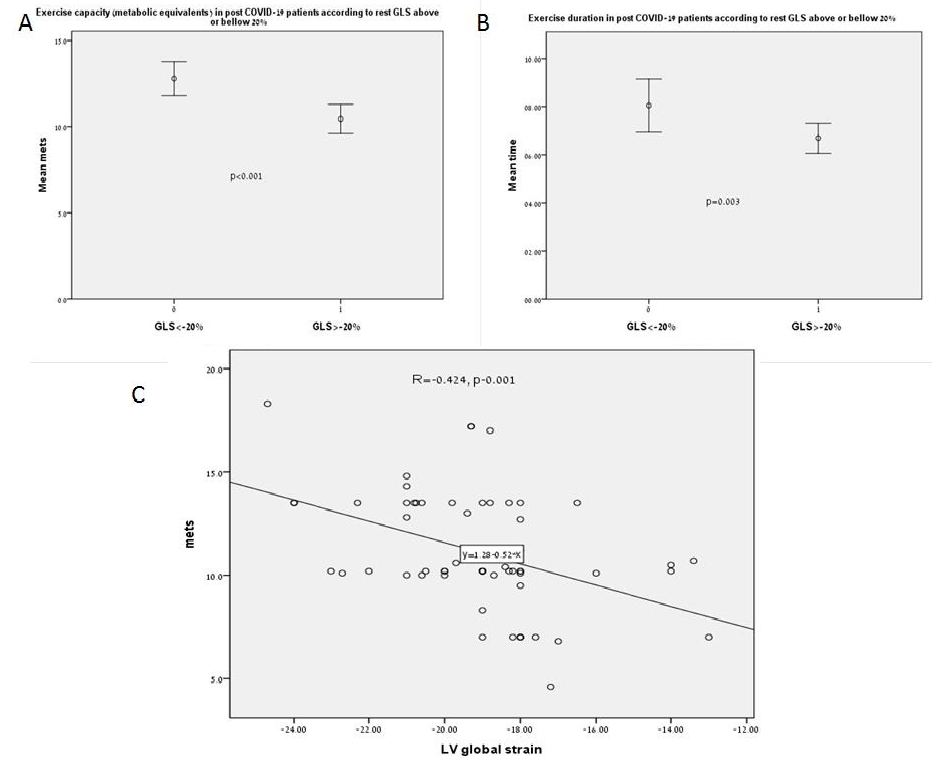
Figure 3. ( A ) Exercise capacity (metabolic equivalents) in post COVID-19 patients according to rest GLS above or under − 20%. ( B ) Exercise duration in post COVID-19 patients according to rest GLS above or under − 20%. ( C ) Correlation between LV strain and exercise